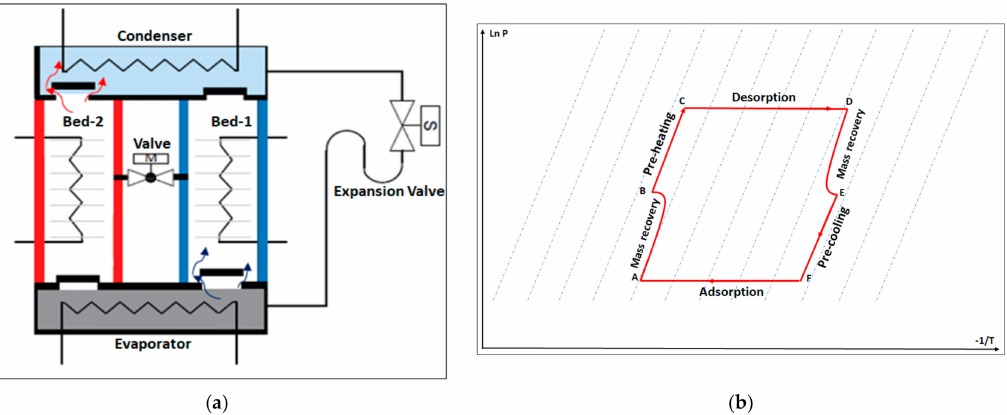
Figure 3. ( a ) Schematic diagram of the adsorption–cooling system. ( b ) Clapeyron diagram of the adsorption–cooling cycle with reheat